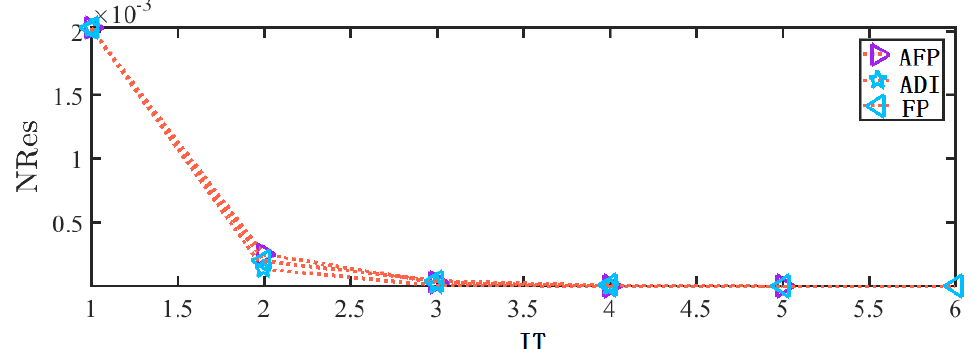
Figure 1. The relation of IT and NRes for the three algorithms when P 0 = Υ .